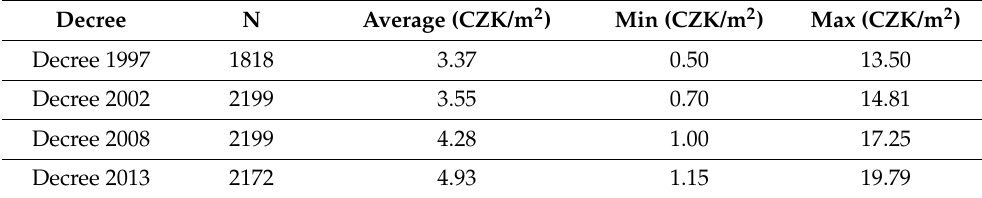
Table 2. Basic descriptive statistics of the evaluated data set (based on decrees).